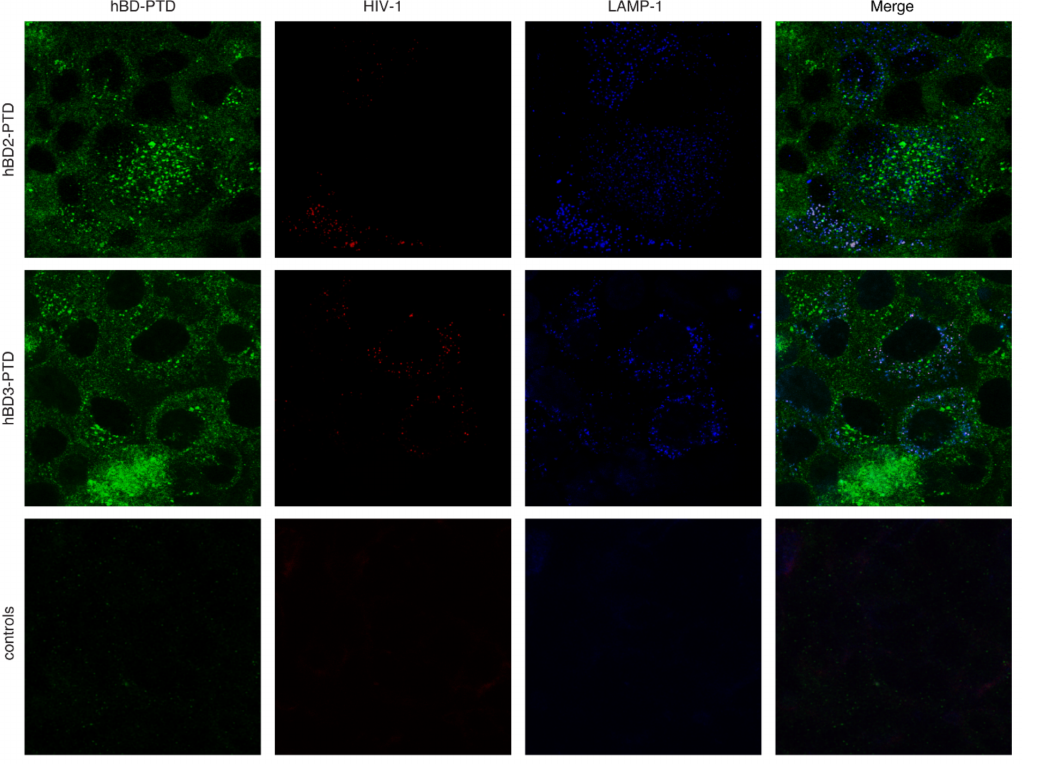
Figure 6. Colocalization of hBD-2 PTD and hBD-3 PTD proteins with HIV-1 in the lysosomes. Polarized tonsil epithelial cells were exposed to HIV-1 SF33 (20 ng/mL); after 48 h, cells were treated with hBD-2 or -3 (50 µ g/mL) with or without PTD signal for 2 h. Cells were fixed and immunostained for antibodies against hBD-2 or -3 (green), HIV-1 p24 (red), and lysosomal marker LAMP1 (blue). Cells were analyzed by confocal microscopy. Magnification: × 630. The white and pinkish-white color in the merged panels indicates colocalization of hBDs, p24, and LAMP1, indicating colocalization of hBDs and virions in the LAMP1-positive lysosomes. Results were reproduced in two independent